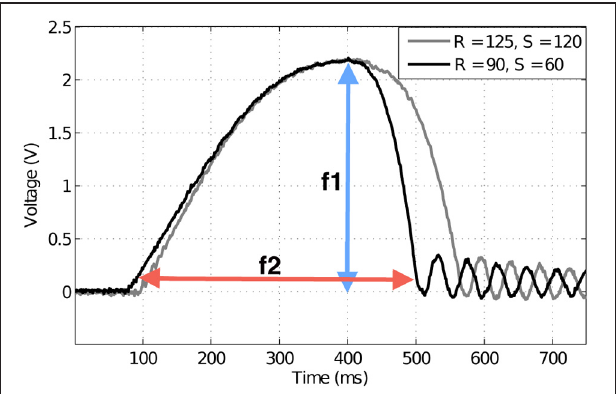
FIGURE 4 | Example deflection signals from the artificial whisker. Magnitude of deflection, or force, has been used previously as a discriminator of radial distance to contact. Here the two traces are at different radial distances (measured in mm), but create the same magnitude of deflection. Speed measured in mm/s. Colored arrows indicate how the extracted features for classification are measured. Peak deflection magnitude f 1 (blue arrow) and contact duration f 2 (red arrow) are used to discriminate radial distance to contact and contact speed,